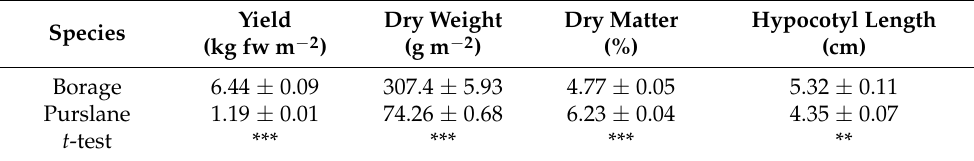
Table 1. Fresh yield, dry weight, dry matter, and hypocotyl length of the two microgreens growing in controlled conditions. Means were statistically separated using a two-tailed Student’s t -test. **: p < 0.01; ***: p < 0.001.